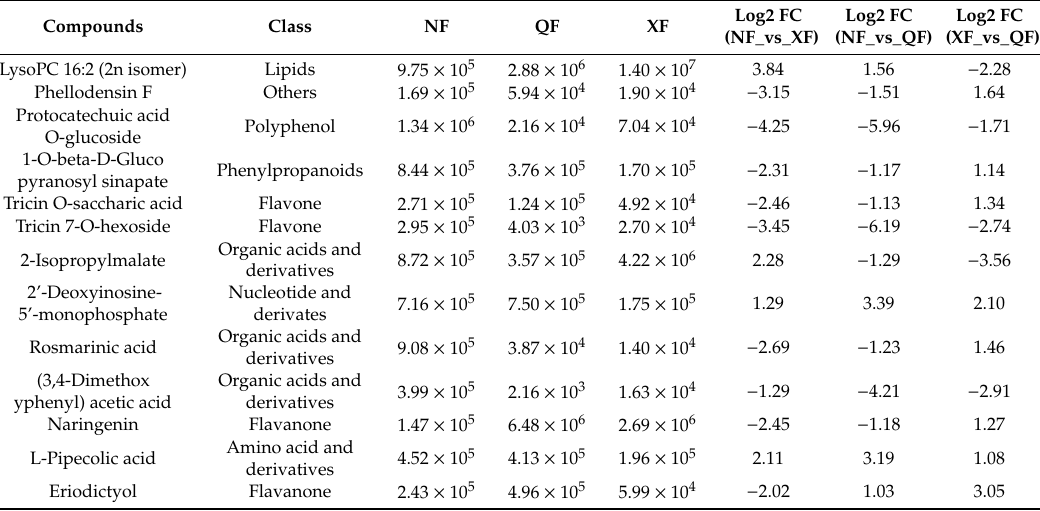
Table 2. List of metabolites showing constitutive di ff erential accumulation between wolfberry fruits from three planting areas.